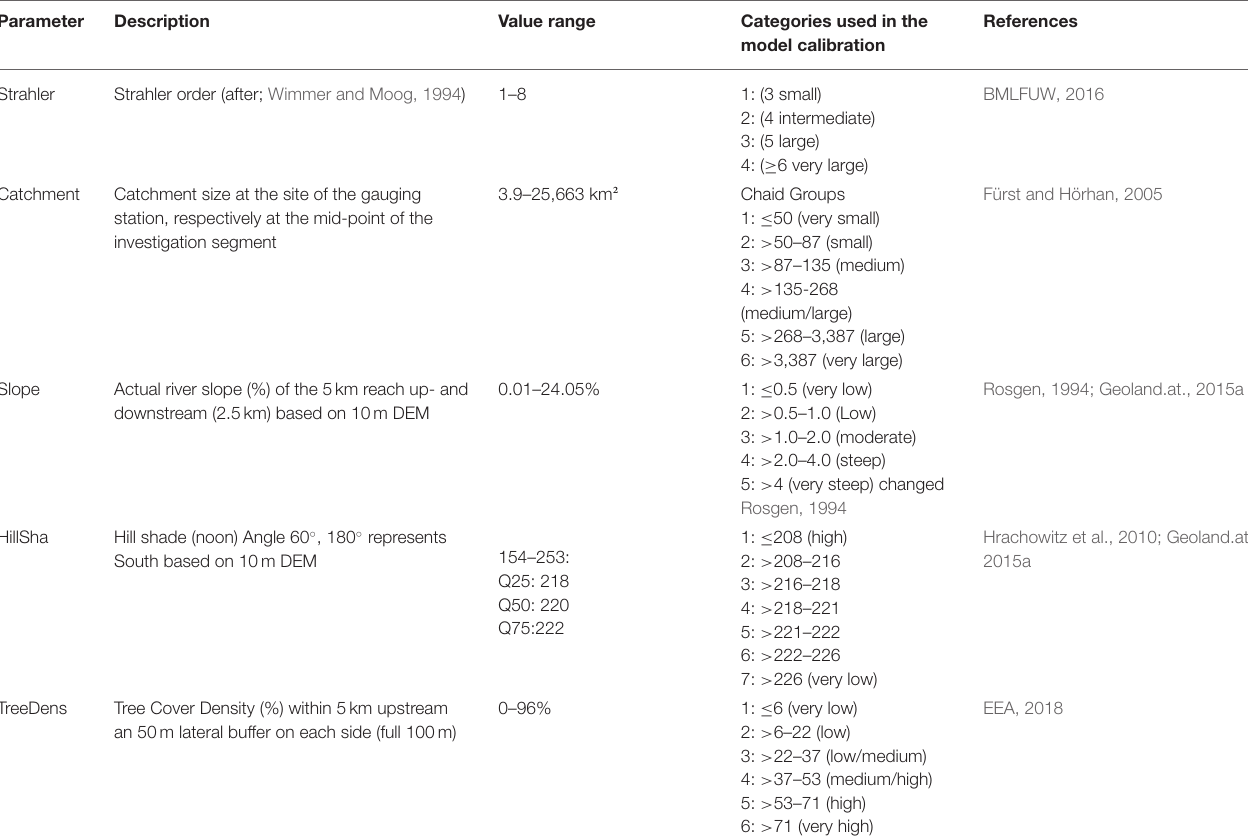
TABLE 1 | Overview and explanation of the descriptors used in the water temperature model, as well as the value ranges in the training data (Value range), the categorized values (Categories used in the model calibration), and the data of the dataset.